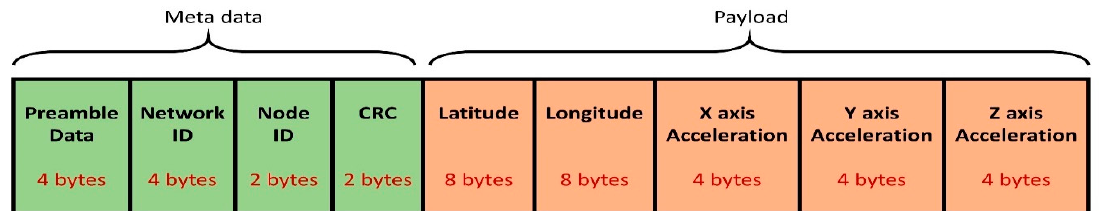
Figure 6. Data packet components and the respective data bytes.